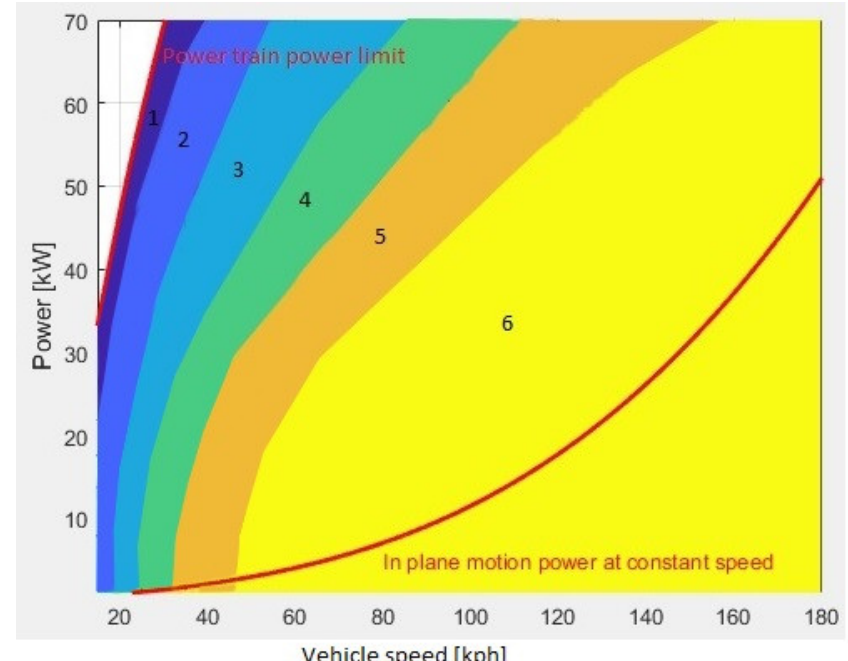
Figure 8. Optimal transmission ratio-Parallel architecture.